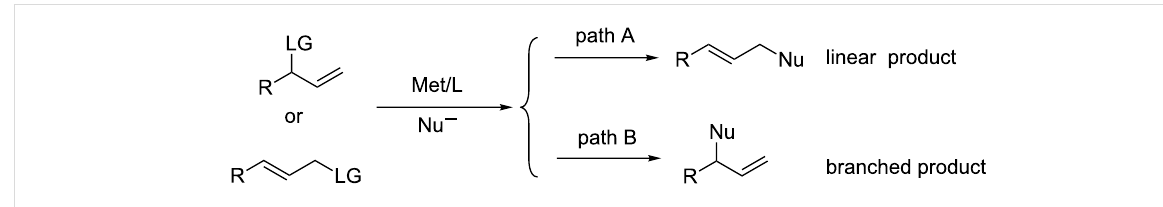
Scheme 1: Transition metal-catalyzed allylic substitution reactions with monosubstituted allyl